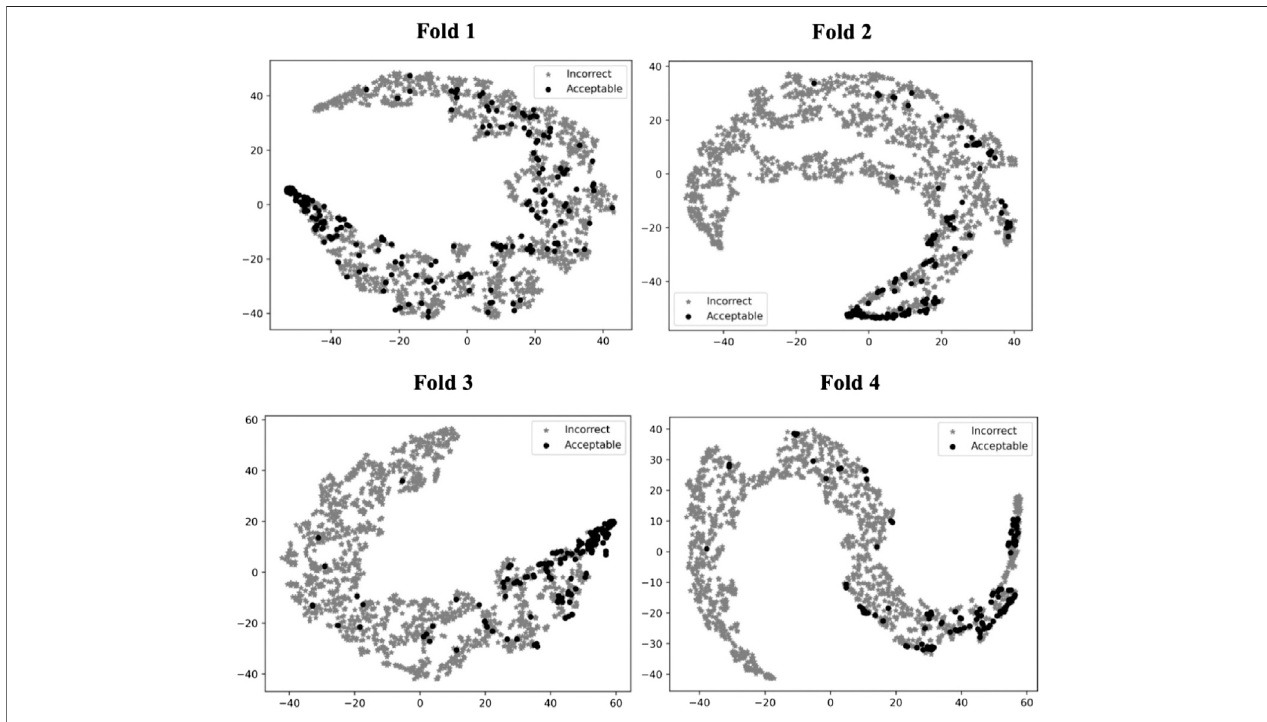
FIGURE 5 | t-SNE plots of decoy selection. Decoys from all the testing target complexes in the four different folds in the cross-testing are plotted, which in total include580correctdecoys(blackcircles)and5,591incorrectdecoys(graystars).Encodedfeaturesofthosedecoysaretakenfromtheoutputofthelastfullyconnected layer of GNN, which is a vector of 128 elements. To visualize the different embedding, we use t-SNE to project them into a 2D space. The four panels correspond to the embedding of models on the four-fold testing sets.